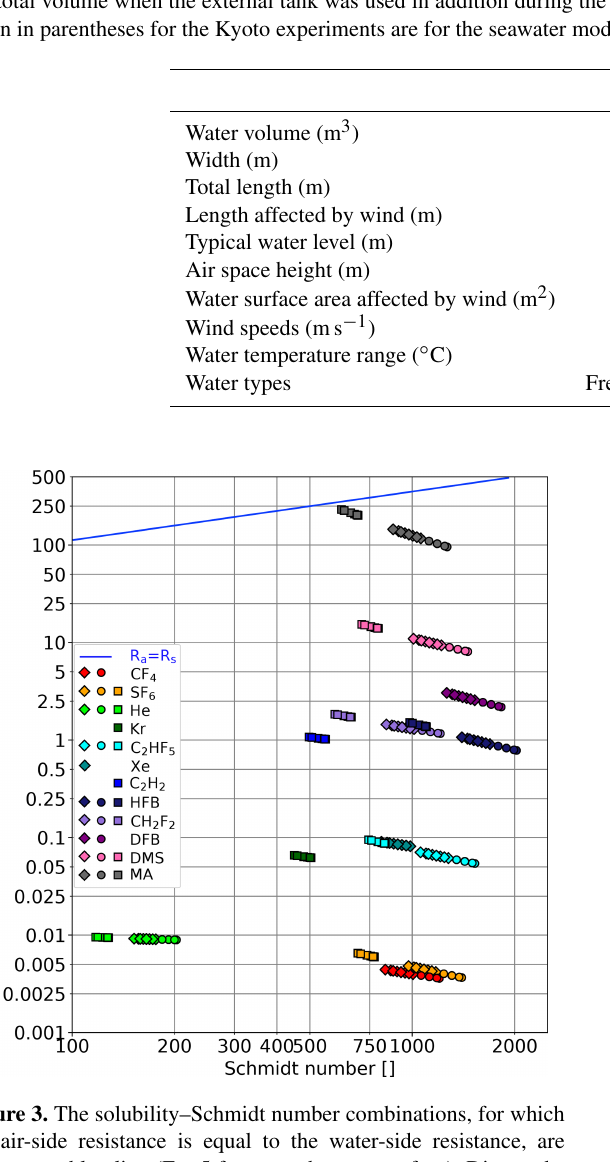
Table 1. Technical data of the wind-wave tanks used. All numbers are approximate. The water volume in parentheses for the Kyoto tank gives the total volume when the external tank was used in addition during the highest wind speed condition. Wind speeds and water temperatures given in parentheses for the Kyoto experiments are for the seawater model.